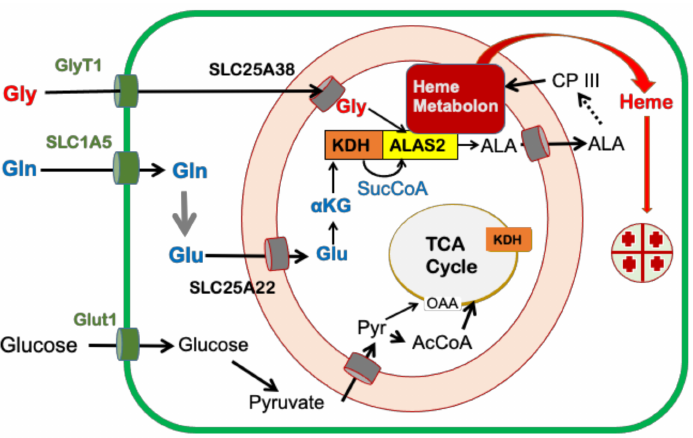
Figure 5. Cellular metabolic pathways that contribute to mammalian heme synthesis during erythro- poiesis. The cartoon adapted from [26] shows the origin of carbon for heme synthesis. The plasma membrane is shown in green and the mitochondrial inner and outer membranes are represented in